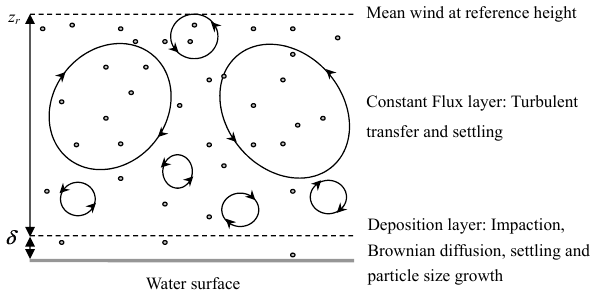
Figure A1. A schematic illustration of the two-layer model for dust deposition to a smooth surface.